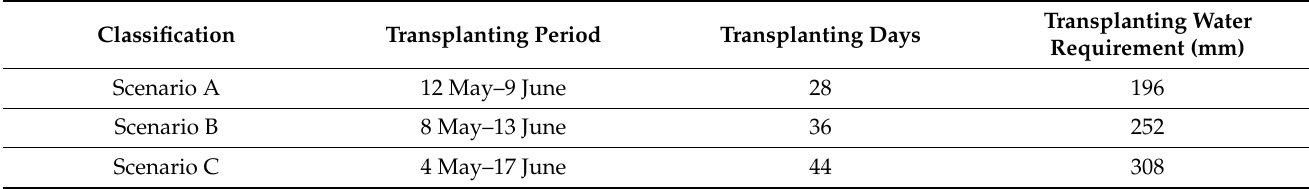
Table 2. Currently changed rice transplanting periods based on the Korea Rural Corporation survey